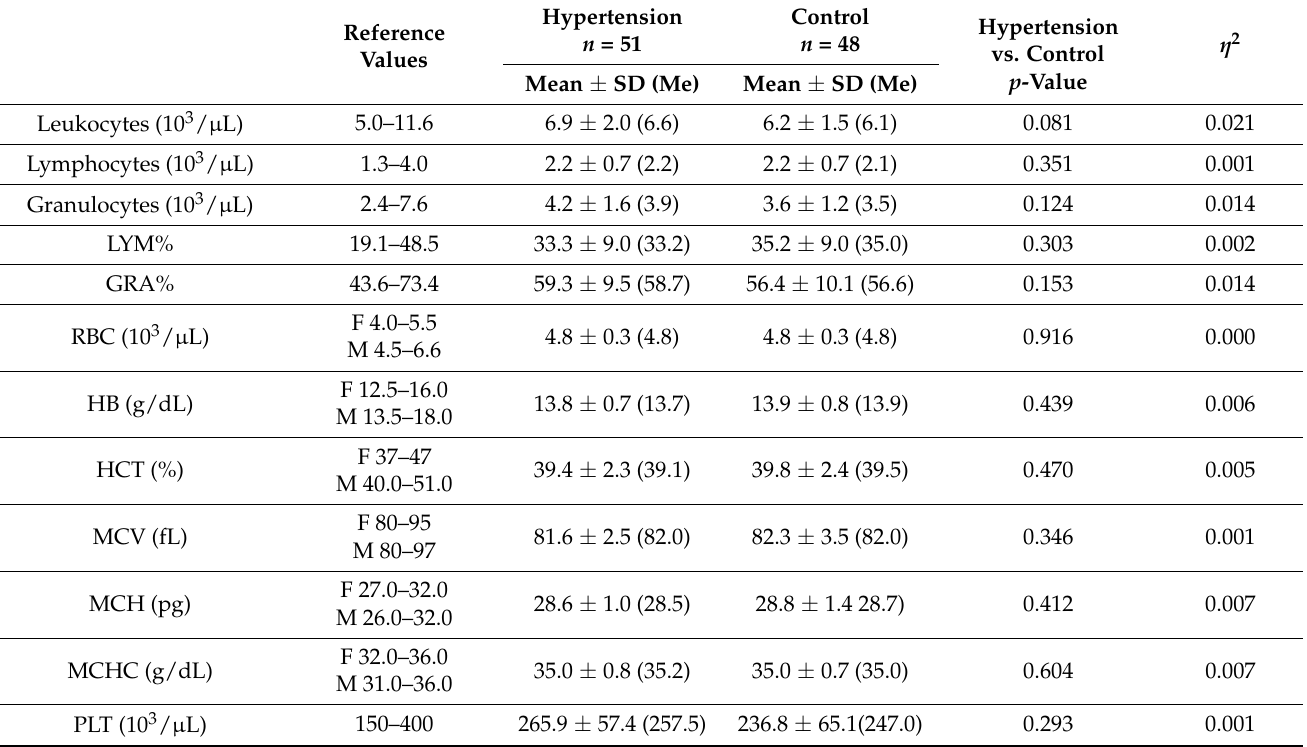
Table 4. Haematological variables (mean ± SD).